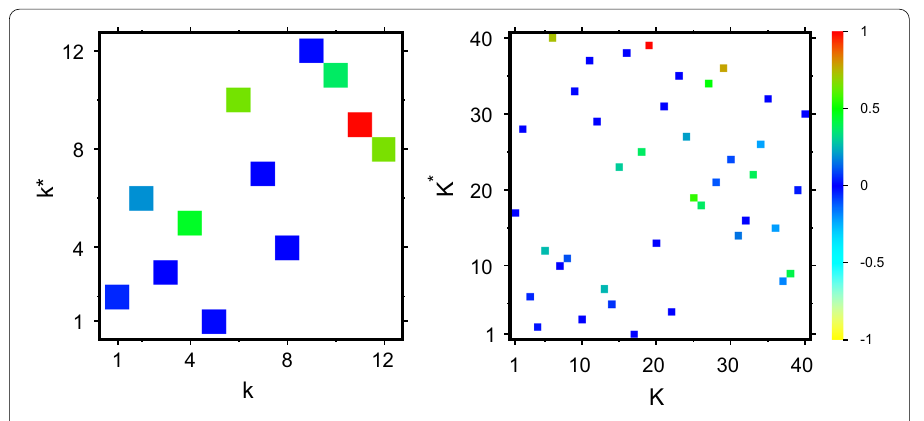
Fig. 8 PageRank magnetization M ( K ) = ( P + ( K ) − P − ( K ))/( P + ( K ) + P − ( K )) presented in the PageRank-CheiRank ( K , K ∗ ) -plane. Left panel: PageRank magnetization M ( k ) for the chosen twelve